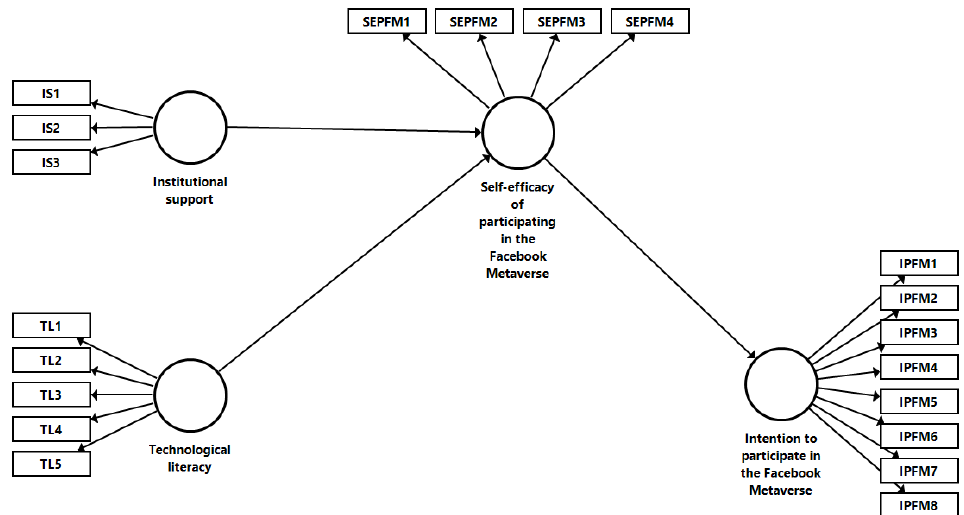
Figure 1. Research model.